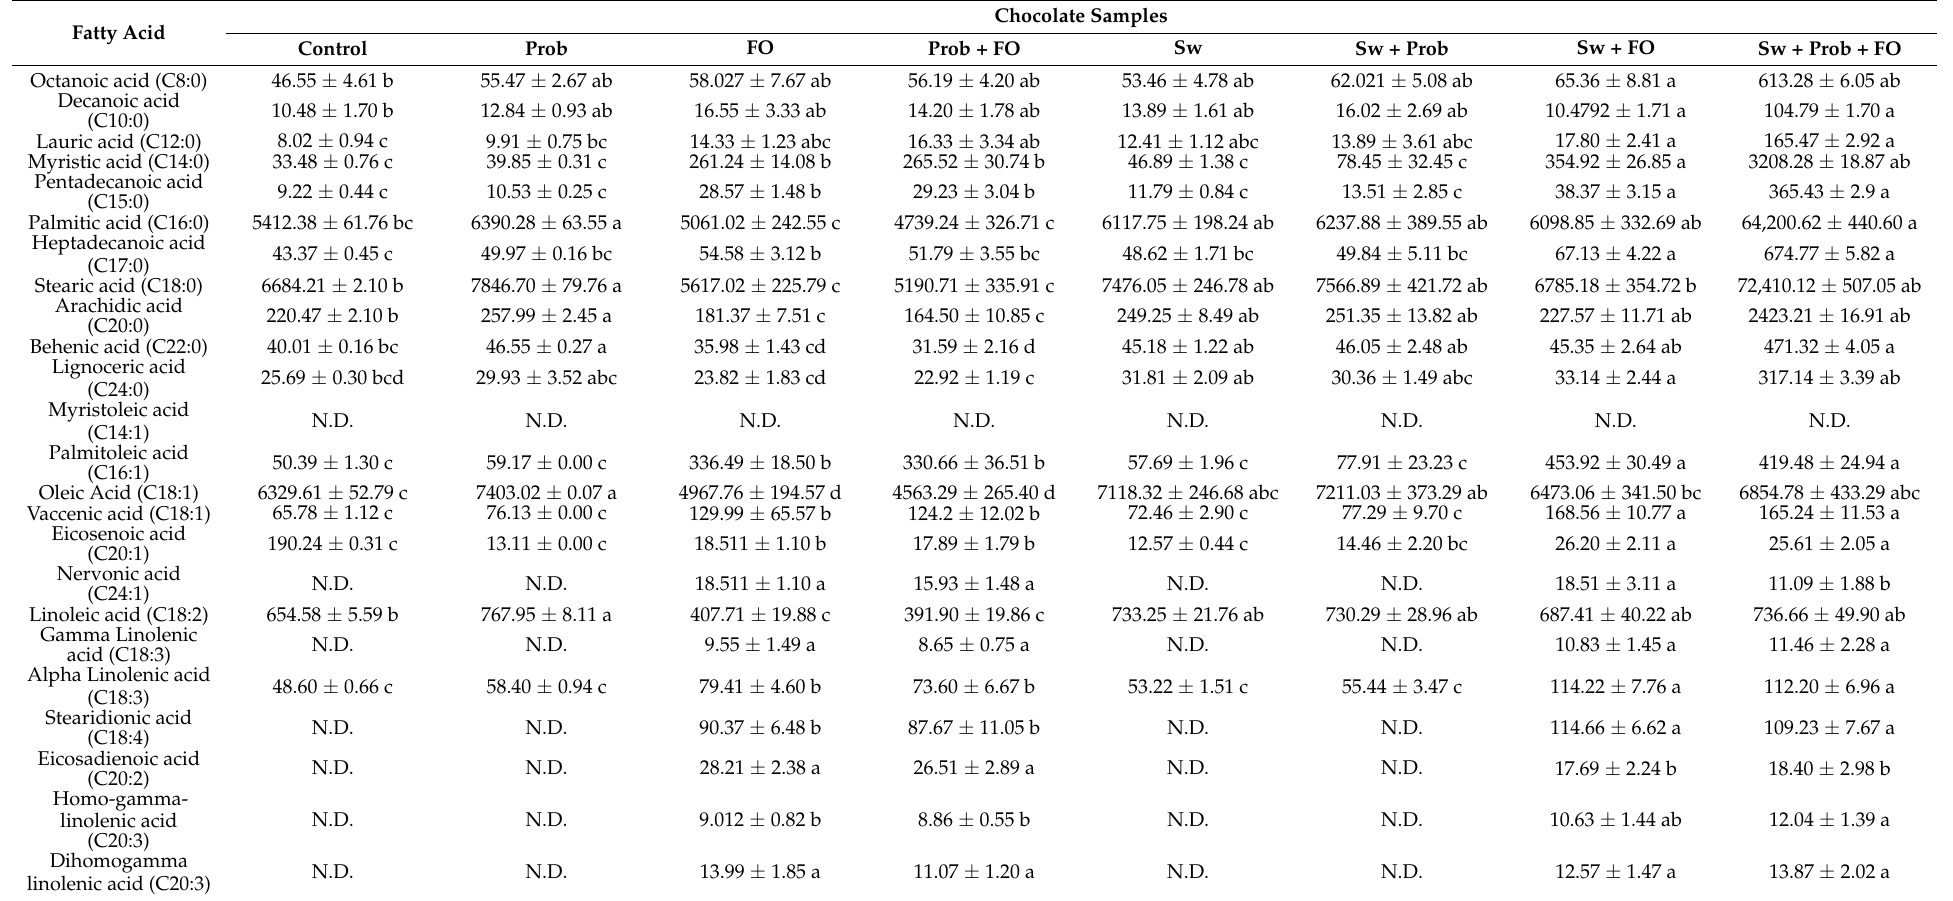
Table 3. Fatty acid profile content (mg fatty acid per 100 g sample FW − 1 ) of fish oil source, milk chocolate with added probiotics and fish oil samples, and sugar-free milk chocolates with added probiotics and fish oil